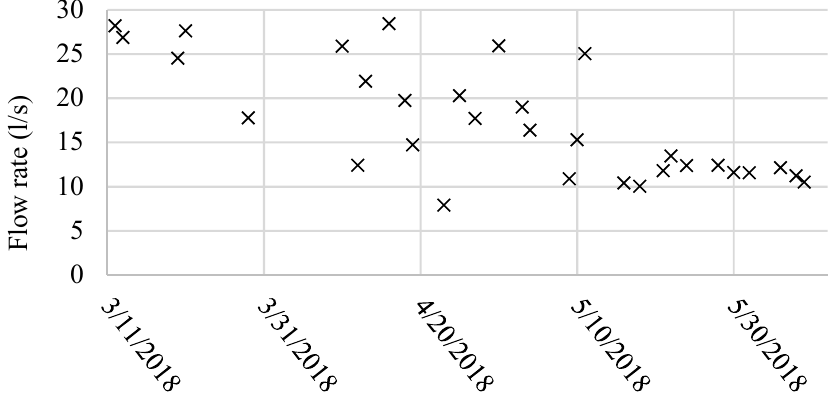
Figure 4. Recorded flow rates from the Connells intake.